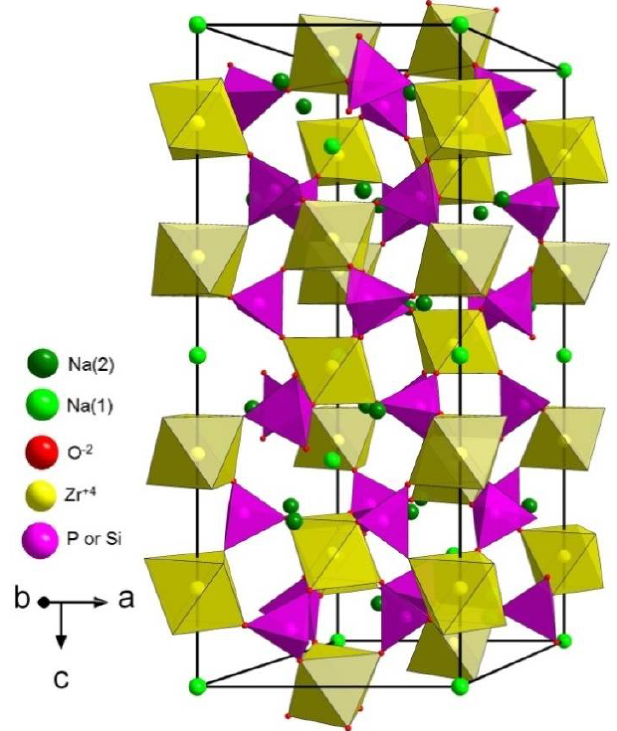
Figure 5. Rhombohedral NaSICON structure indicating the ZrO 6 octahedra, (P/Si)O 4 tetrahedra and sodium atoms. The structural data are taken from [28]. The figure shows the hexagonal unit cell of the NaSICON lattice, which exists above 150 °C in all NAYZSiP x compositions.